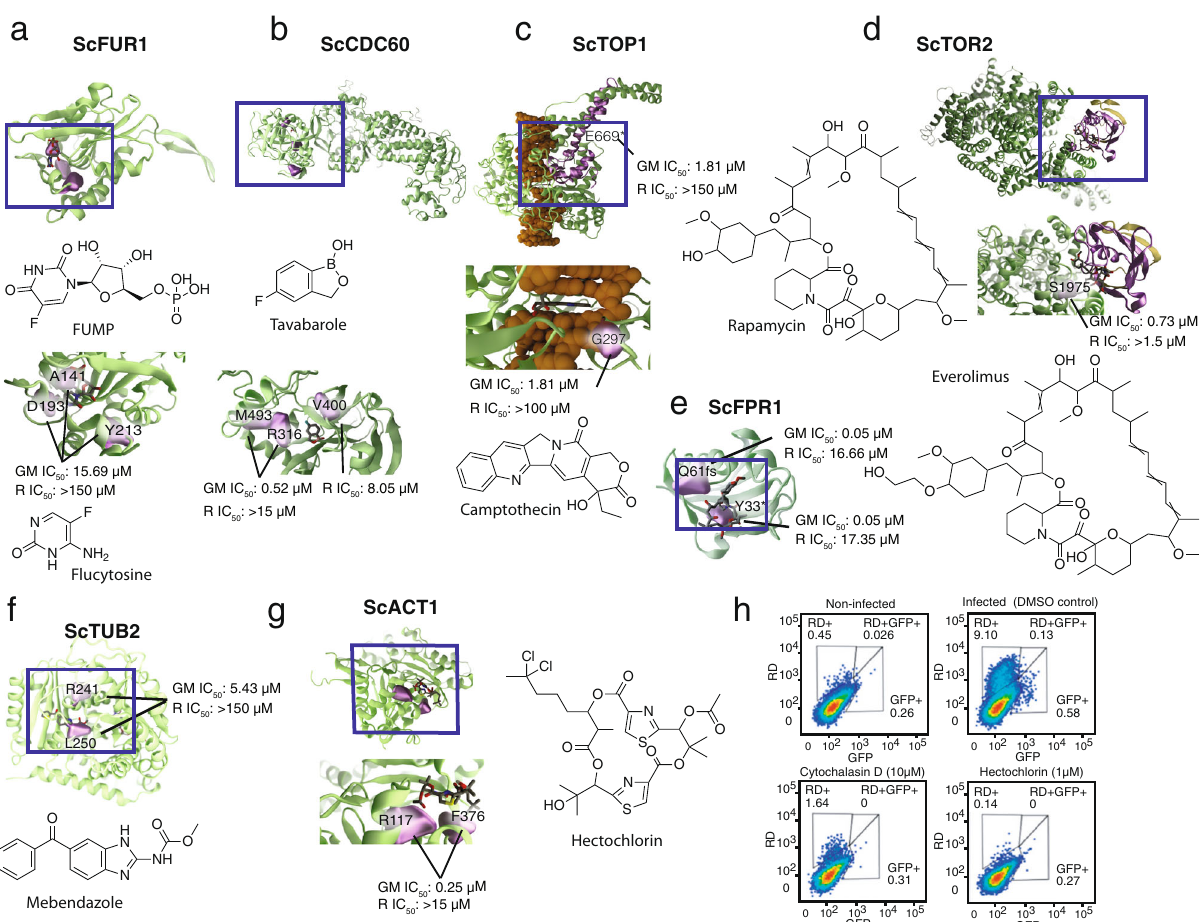
Fig. 4 Resistance-conferring mutations in detail. Proteins and DNA are shown in green and orange, respectively. R = resistant line, GM = green monster parents. a Fur1 in complex with 5-FUMP. Sc Fur1 homology model, with a bound 5-FUMP analog (uridine monophosphate) taken from an aligned holo Tm Fur1 crystal structure (PDB ID: 1O5O). b Cdc60 model. Cdc60 homology model bound to a docked tavaborole molecule. c Top1 model. DNA-Top1- camptothecin complex, modelled using a Sc Top1 crystal structure (PDB: 1OIS), with bound camptothecin taken from an aligned holo Hs Top1p crystal structure (PDB: 1T8I). d Tor2 model. mTOR-rapamycin-Fpr1 tertiary complex model, modelled using a crystal structure of the human complex as a template (PDB ID: 4DRI 107 . mTOR residues 1001 – 2474 are shown in green (homology model), and Fpr1 is shown in yellow (crystal structure, PDB: 1YAT). e Fpr1-rapamycin model. Fpr-rapamycin (crystal structure, PDB 1YAT). f Tub2-nocodazol model. Tub2-nocodazol (crystal structure, PDB: 5CA1). g Act1 model. Act1 (crystal structure, PDB: 1YAG), bound to a docked hectochlorin molecule. Evaluation of hepatocellular traversal by P. berghei sporozoites using an established fl ow cytometry-based assay 108 . h Liver cell invasion assay. Flow cytometry plots show traversal and invasion of host cells at 2 h post- invasion by exoerythrocytic forms in Huh7.5.1 cells. The percent of rhodamine-dextran positive single cells (RD) was used to determine overall